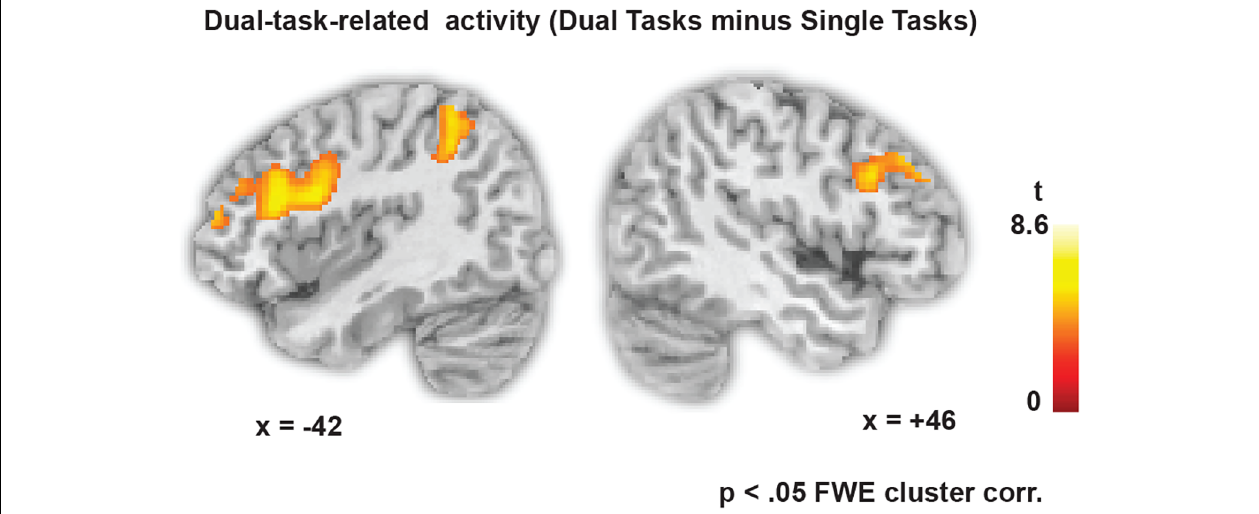
FIGURE 3 | Dual-task-specific brain activity, revealed by contrasting all dual-task blocks with all single-task blocks ( p < 0.05 FWE cluster-corrected, p < 0.001 at the voxel level). TABLE 1 | Activity peaks for the contrast dual tasks minus single tasks. Region (labels for k > 10) Hem Brodman n MNI coordinates T -value cluster size Area x y